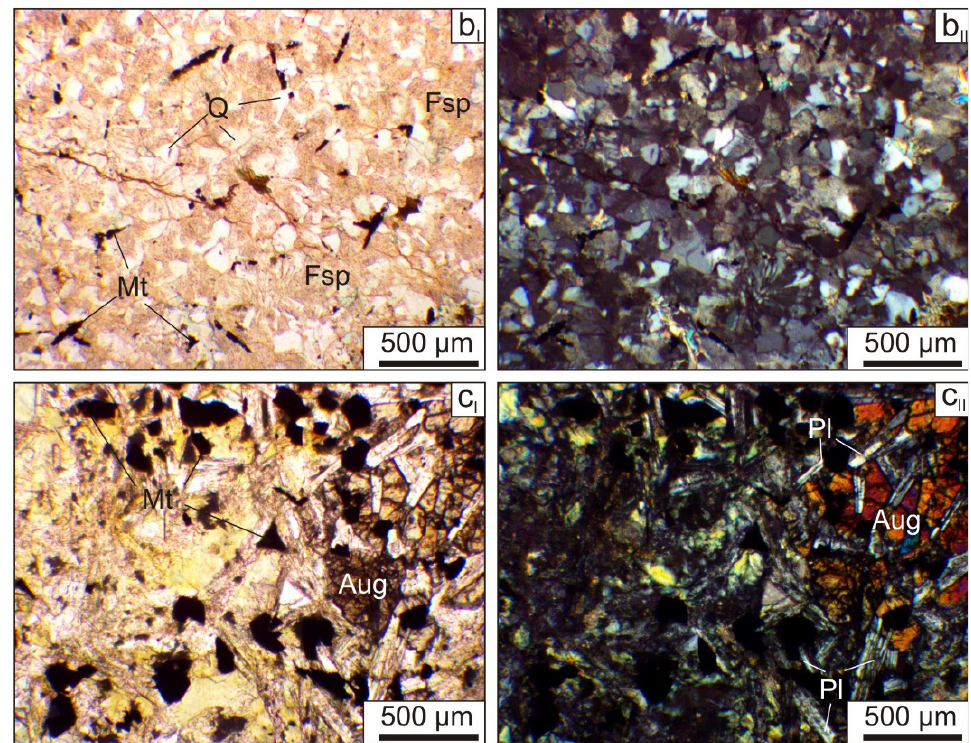
Figure 4. Microphotos of ( a I ) riebeckite granite in plane-polarized light, ( a II ) riebeckite granite in cross-polarized light, ( b I ) aplitic rock in plane-polarized light; ( b II ) aplitic rock in cross-polarized light; ( c I ) doleritic rock in plane-polarized light, and ( c II ) doleritic rock in cross-polarized light from the Tannuola terrane. Pl—plagioclase; Fsp—K-feldspar; Q—quartz; Rbk—riebeckite; Aug—augite; Mt—magnetite.